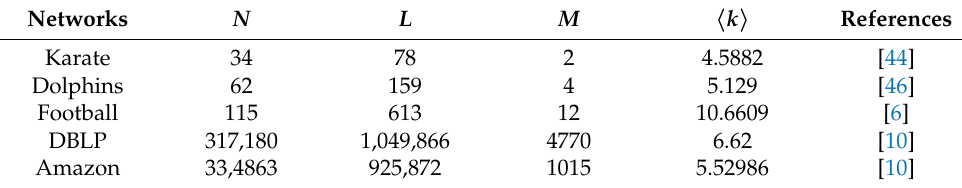
Table 1. The structure parameters and the community number of networks. For each network, parameters N , L and m represent the numbers of nodes, edges and standard communities respectively, and (cid:104) k (cid:105) represents the average degree of all nodes in the network. Networks N L M (cid:104) k